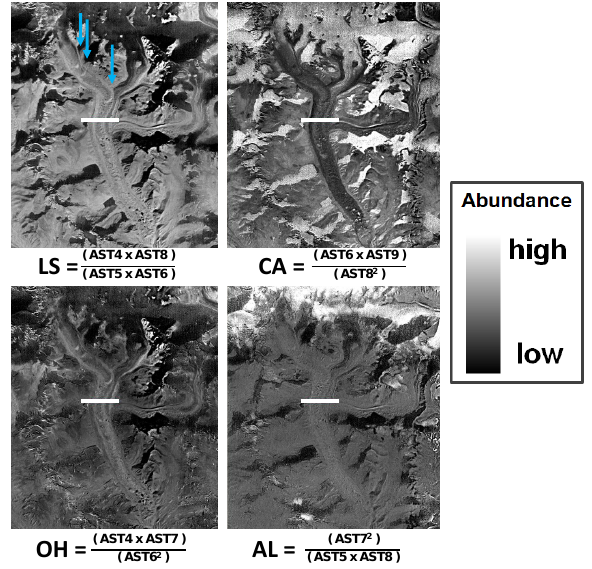
Fig. 5. ASTER SWIR radiance based mineral abundance maps of Ngozumpa supraglacial debris, clockwise from the top left, layered silicate, calcite, alunite and hydroxyl bearing. Cyan arrows on the layered silicate index point to evidence of pulse like glacial flow. The location of the transect used to investigate differing mineral abundances with respect to supraglacial temperatures in Fig. 7 are indicated by the white lines across Ngozumpa